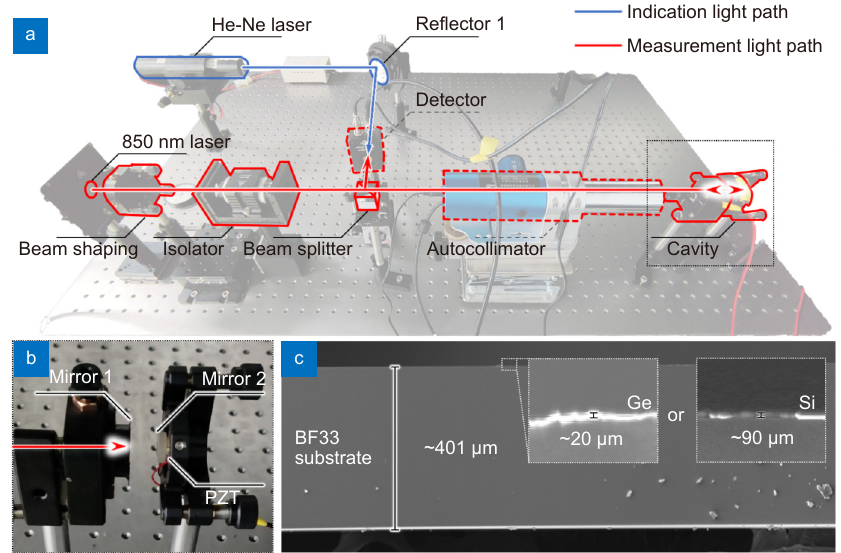
Fig. 7 | ( a ) Experimental configuration of the cavity-based displacement measurement. ( b ) Magnified view of the length tunable F-P cavity. ( c ) Cross-sectional view of mirror 1, along with the SEM images of the Ge film and the Si film in the